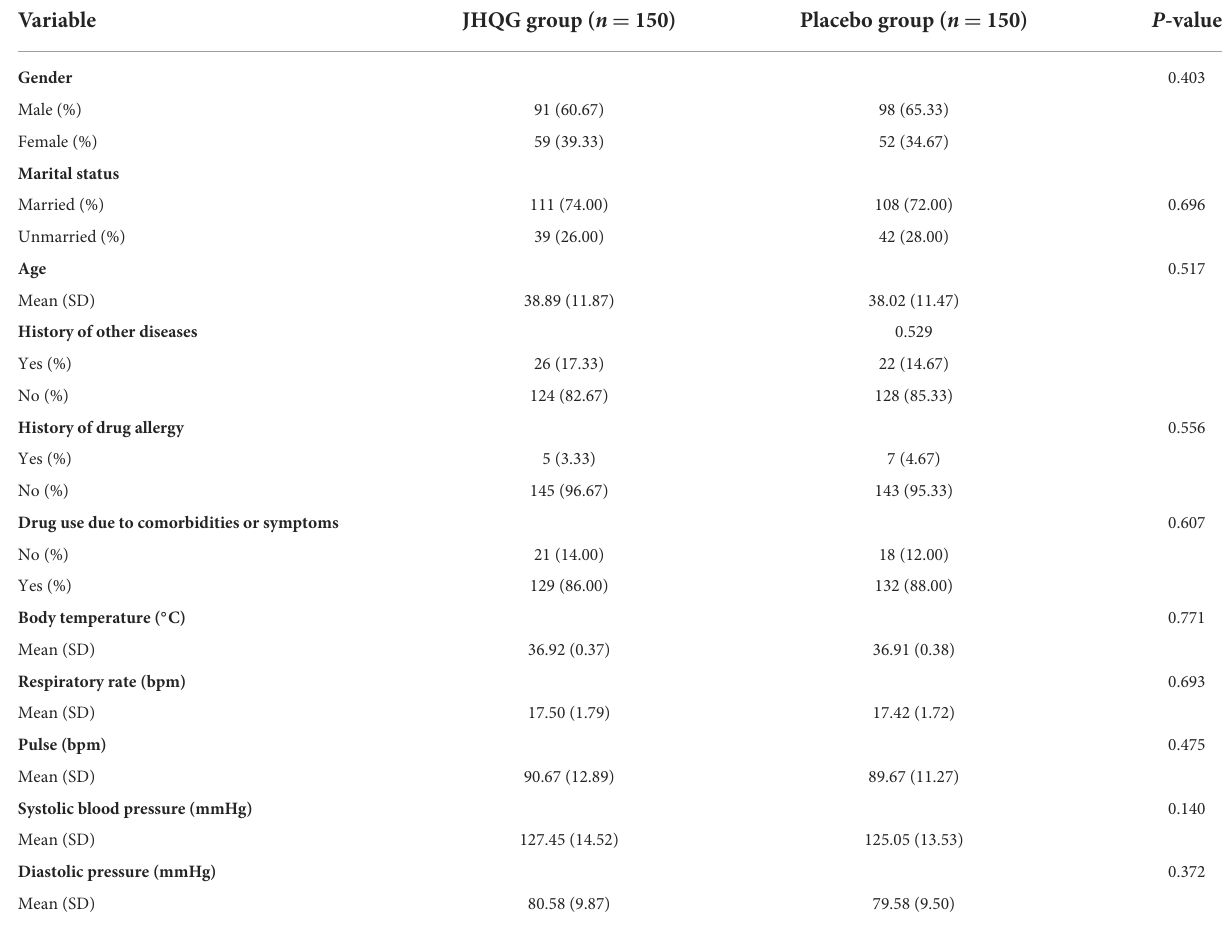
TABLE 1 Demographics and baseline characteristics of the subjects in the